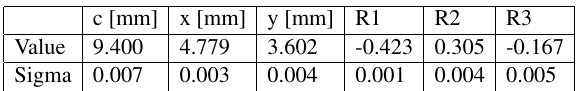
Table 2. Bundle block adjustment: Camera self calibration re- sults and uncertainties for focal length x, principal point (x,y) and the radial distortions R1, R2, R3. Further distortion coefficients skipped, as they are not significant.